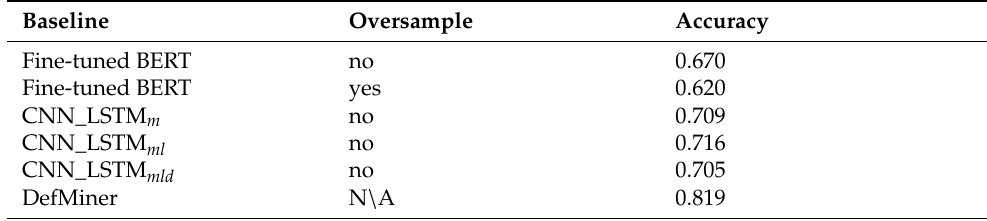
Table 3. Final results for the W00